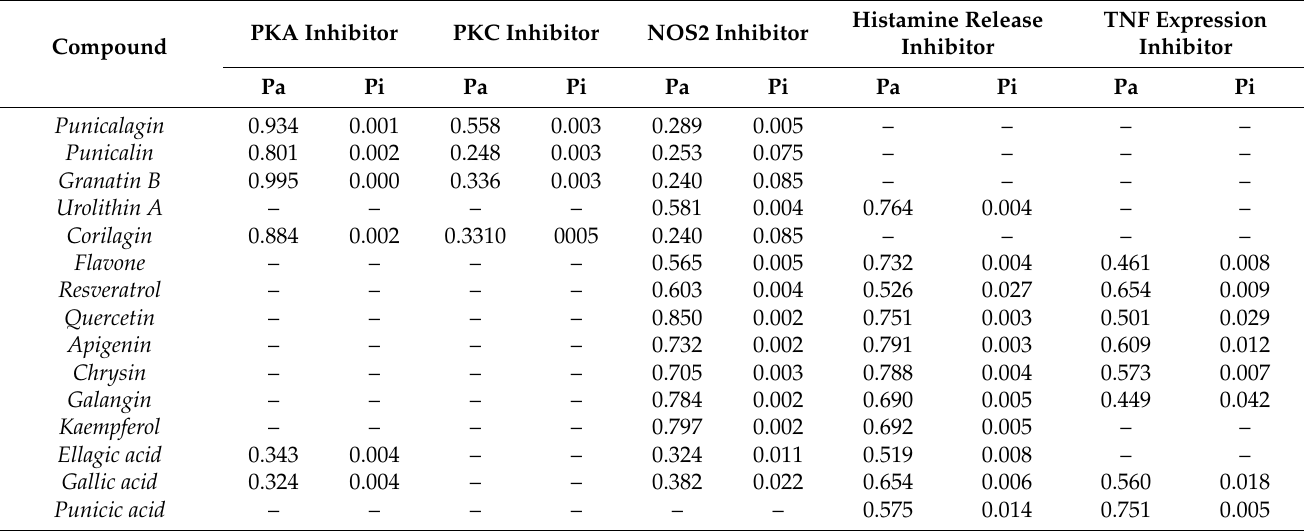
Table 2. Molecular mechanism predicted for major compounds by